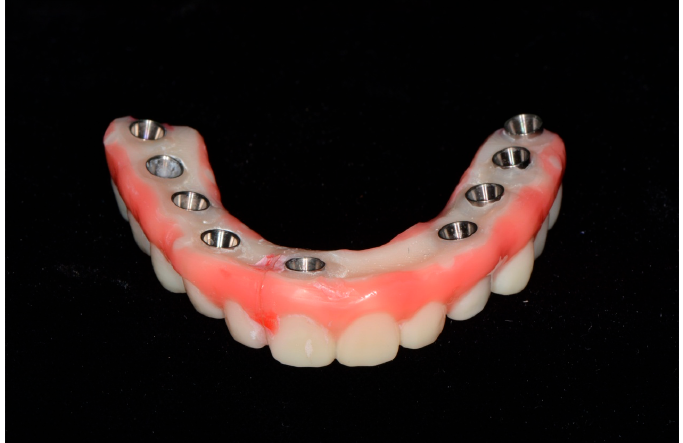
Figure 9. Provisional prosthesis with cylinder access holes.